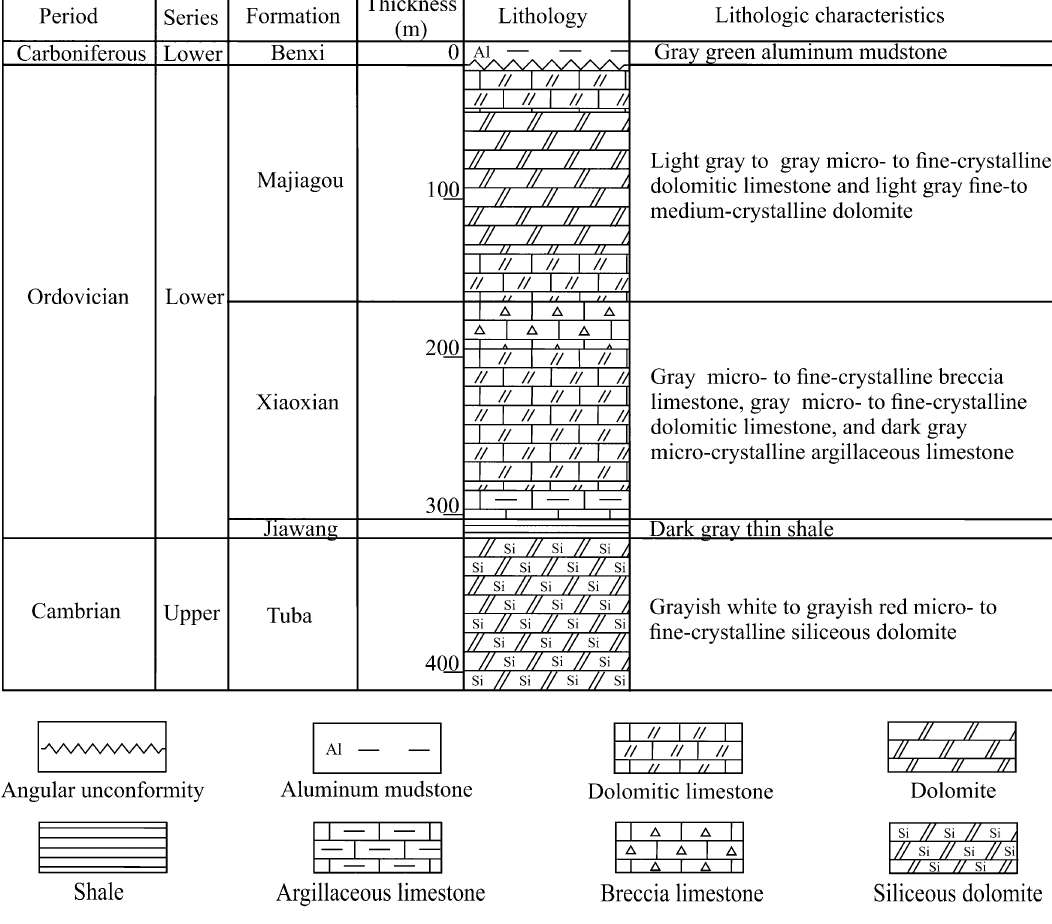
Figure 2. The Ordovician stratigraphic column of the in-situ system in the Huai-Fu